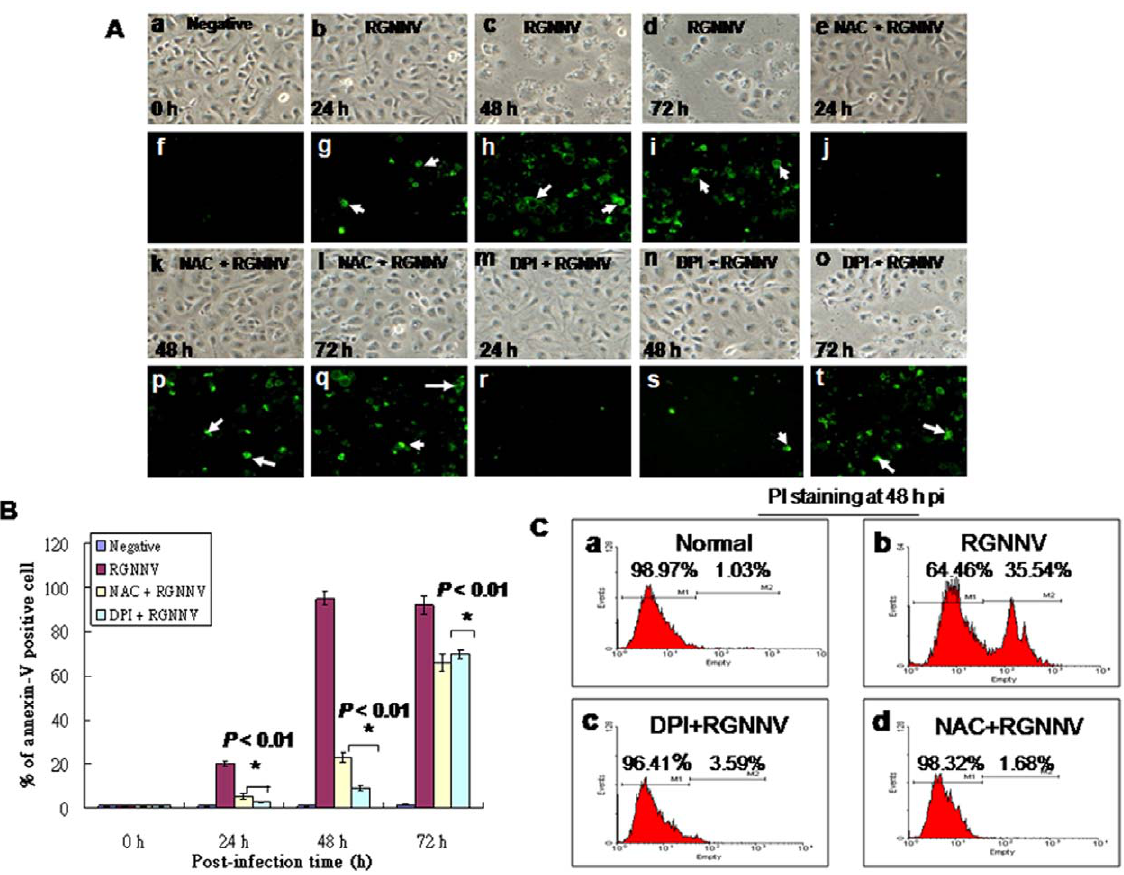
Figure 4. Identification of anti-oxidants treatment can reduce apoptotic/necrotic death of cells infected with RGNNV. (A) Phase- contrast and fluorescent micrographs of annexin-V–stained, RGNNV-infected GF-1 cells without drug-treatment at 0 h (a and f), 24 h (b and g), 48 h (c and h), and 72 h (d and i) or with NAC-treatment at 24 h (e and j), 48 h (k and p), and 72 h (l and q) and DPA-treatment at 24 h (m and r), 48 h (n and s), and 72 h (o and t). Annexin-V–positive cells (necrotic cells) are indicated by arrows. Scale bar=20 m m. (B) The number of annexin-V–positive cells after infection with RGNNV at 0, 24, 48, and 72 h. Statistical comparisons were made using either a paired or unpaired Student’s t -test, as appropriate. * P , 0.05. (C) Examples of flow cytometric profiles in 48 h pi. RGNNV-infected cell and plus anti-oxidants treatment cells PI staining fluorescence was measured from 10,000 cells. Numbers in second peak scales (PI + ) show late apoptotic/secondary necrotic cell percentages respectively. Viable cell percentage (PI 2 ) is shown in first